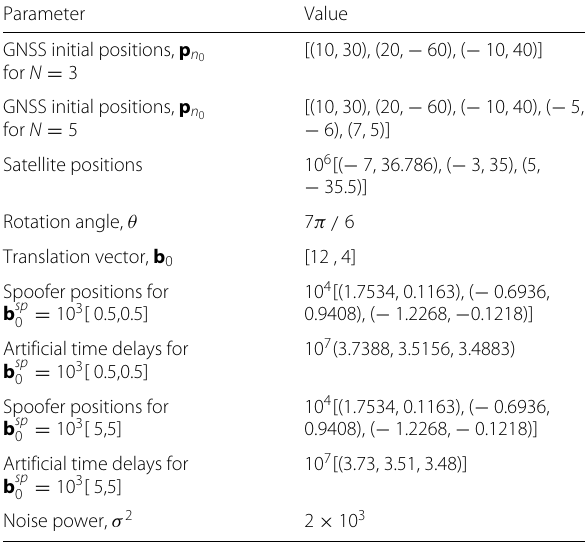
Table 2 Simulations parameters for the spoofing scenario Parameter